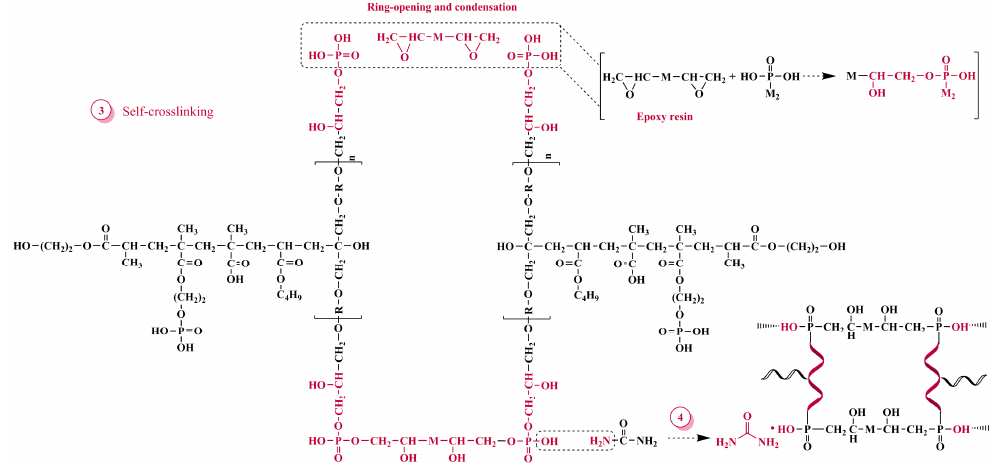
Figure 4. Synthesis route of HPA-EPPA-UR-PA resin.